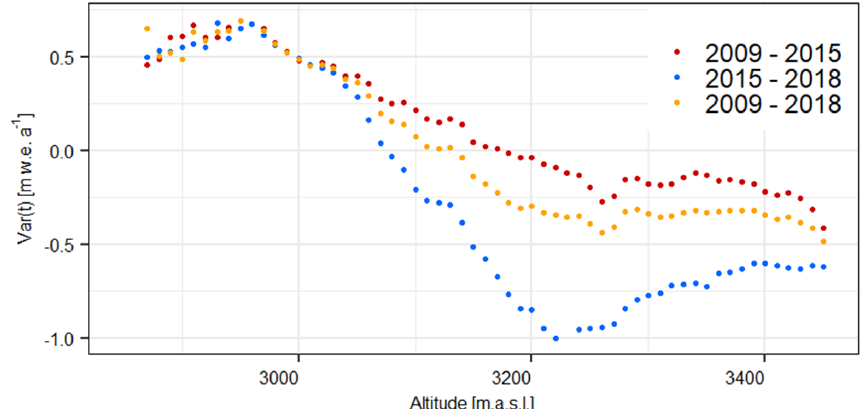
Figure 9. Methodical variations between annual geodetic (corrected) and glaciological mass balances, depending on the altitude [mw.e.a − 1 ] for all periods t ; positive values are present where B glac , t < B geod , t , and negative values are present for the opposite relation; see Eq.